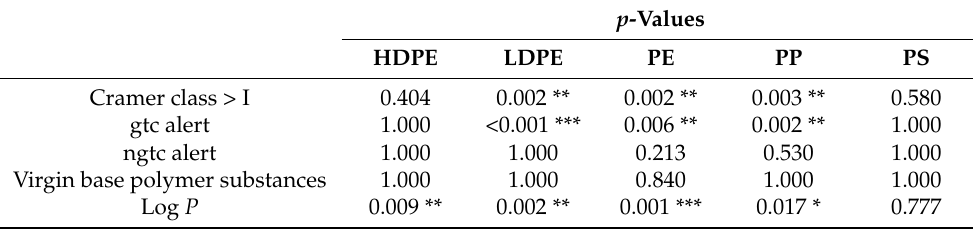
Table 2. Results of the Dunnett’s tests for each polymer with PET for the parameters no. of substances with Cramer classification > I and no. of substances with log P class 4 and results of the X 2 -tests for the parameters no. of substances with gtc and ngtc alerts and no. of virgin base polymer substances. Note: * significance with p ≤ 0.05; ** significance with p ≤ 0.01; *** significance with p ≤ 0.001. p -Values HDPE